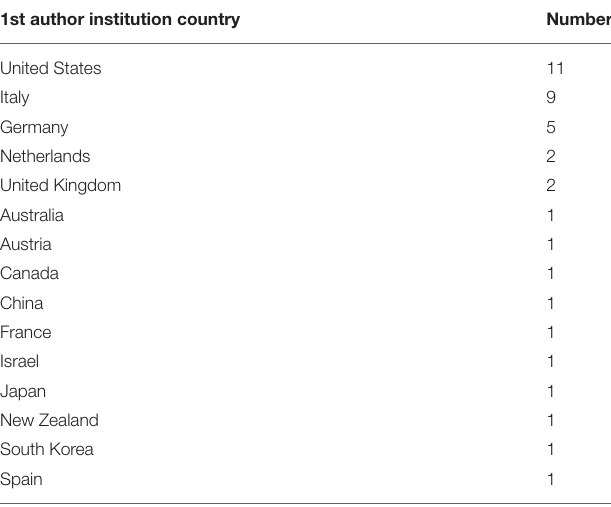
TABLE 1 | List of countries represented in the Research Topic, based on first author’s